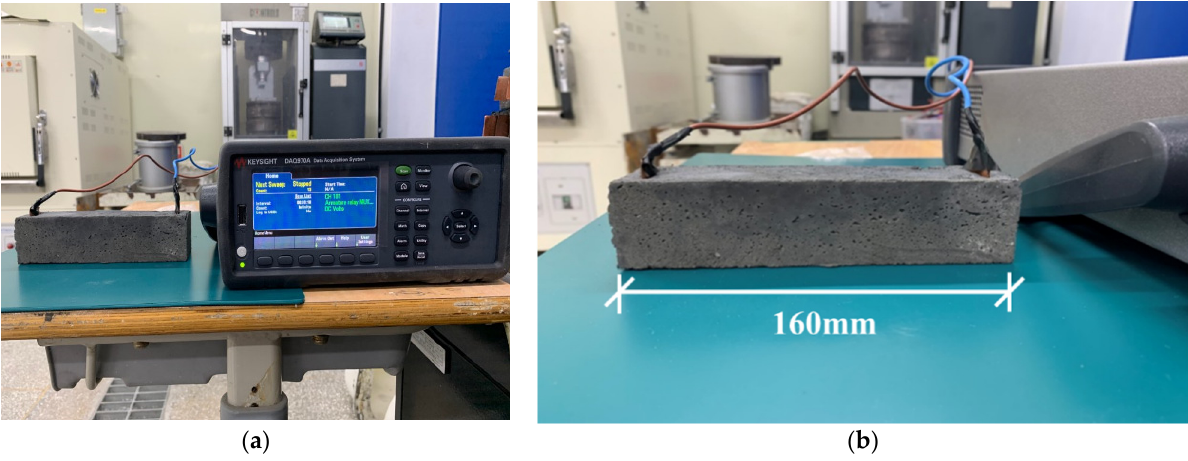
Figure 4. Schematic of cementitious composites for electrical resistance test: ( a ) specimen and device; ( b ) side view.